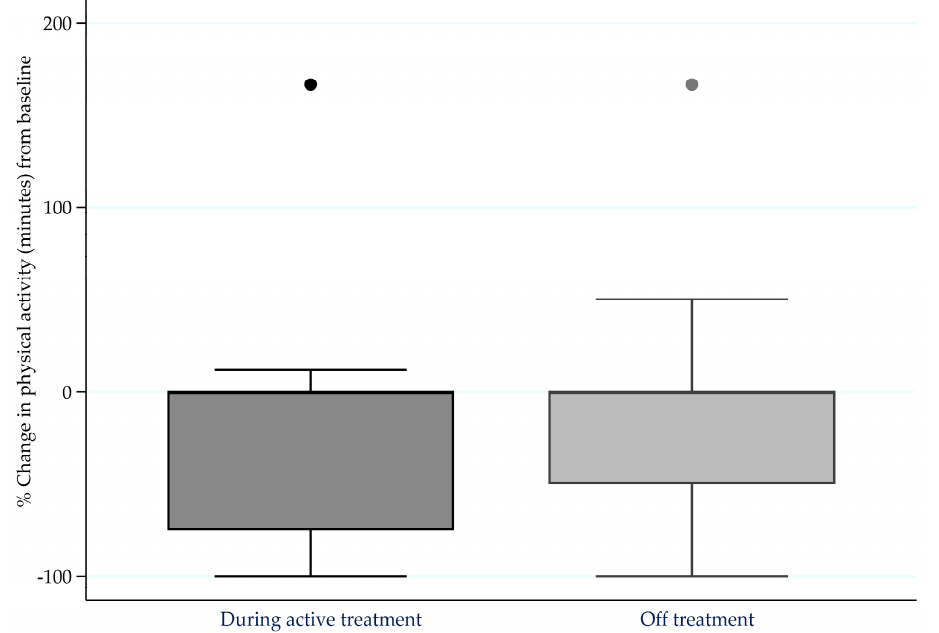
Figure 1. Percentage change in moderate-to-vigorous intensity physical activity (minutes) from pre-diagnosis levels to during active treatment ( n = 109) and whilst off treatment ( n = 70) for more than four weeks.